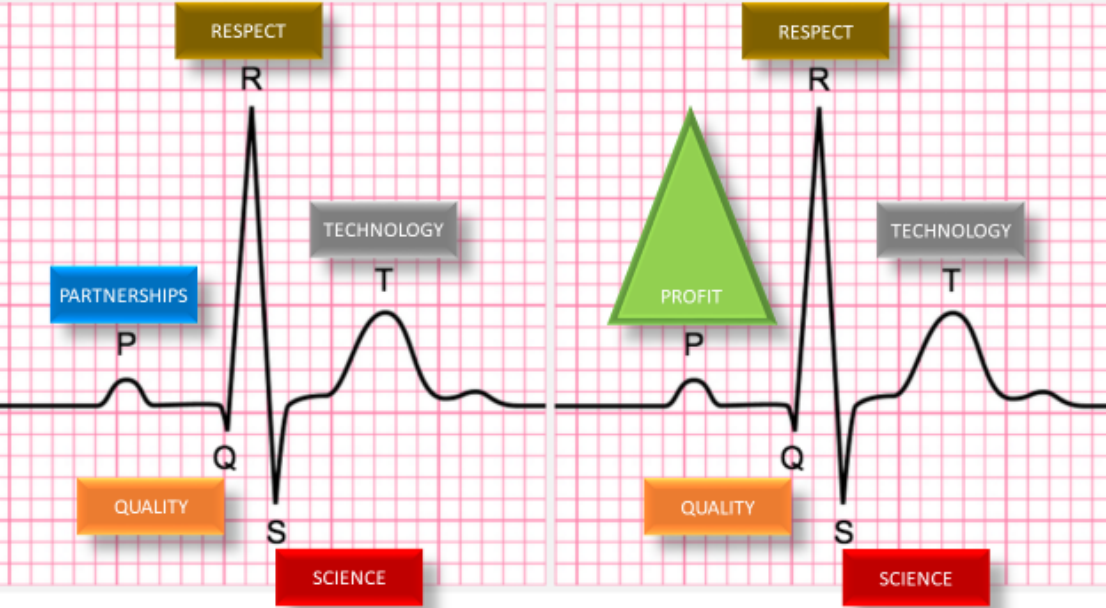
Fig. 12 . Profit from business value of partnerships may exceed profit from profit-driven busi-